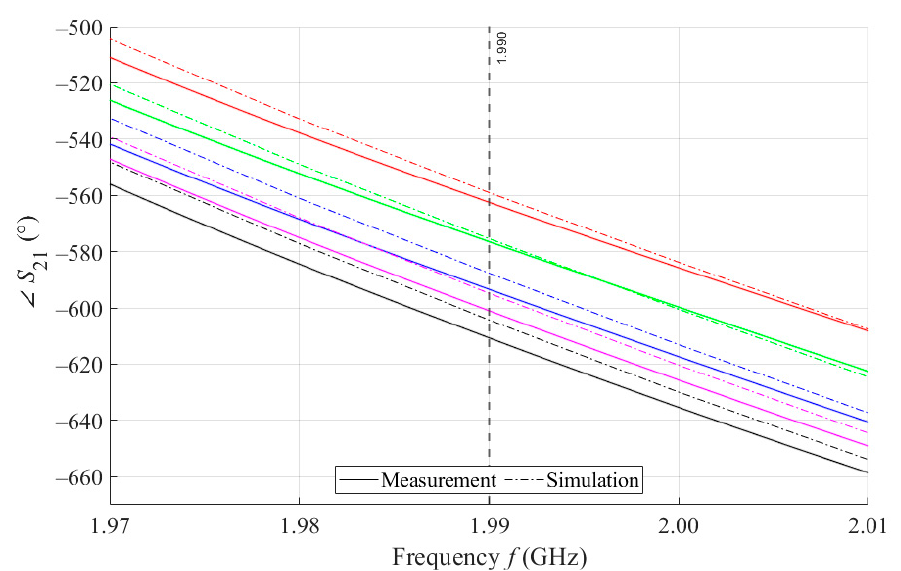
Figure 10. Detail of MTM9 at 1.99 GHz and 4 mL.